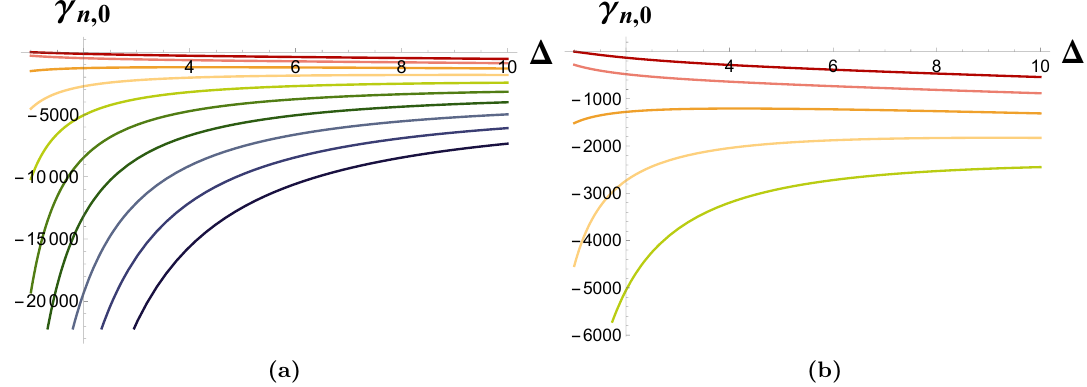
Figure 5. The complete contributions to ‘ = 0 anomalous dimensions due to stress tensor exchange, (cid:12) (cid:13) n; 0 , for 1 (cid:20) n (cid:20) 10, plotted as a function of (cid:1) (cid:21) 1. The red line is n = 1, with increasing n as (cid:12) T we move through the rainbow. All results are negative. In the right plot, we show only 1 (cid:20) n (cid:20) 5 to make clear that these lines sit below the x